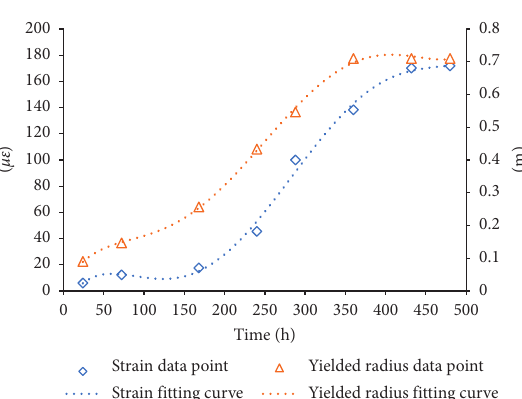
Figure 15: Strain versus time after drilling pressure relief